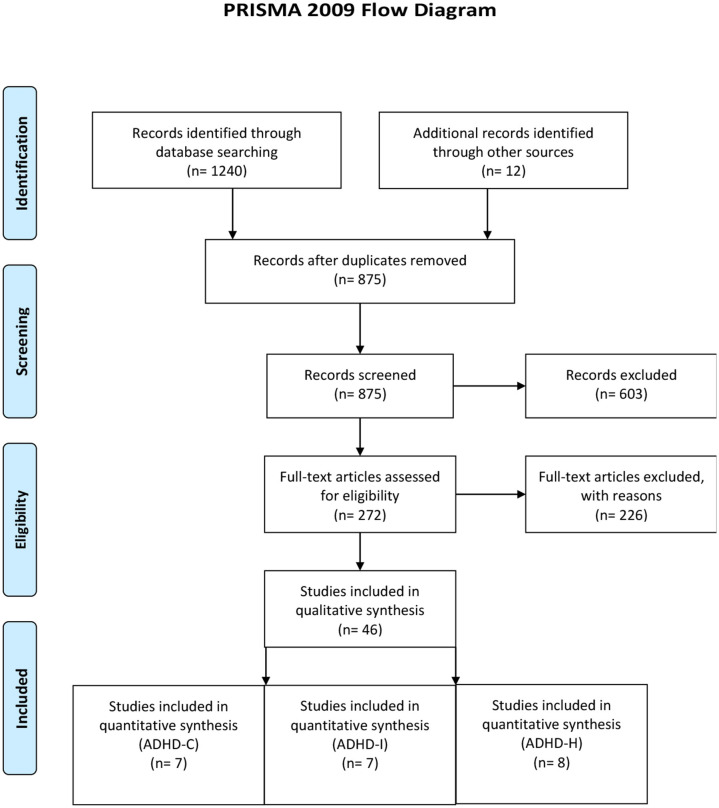
Prisma flow diagram.